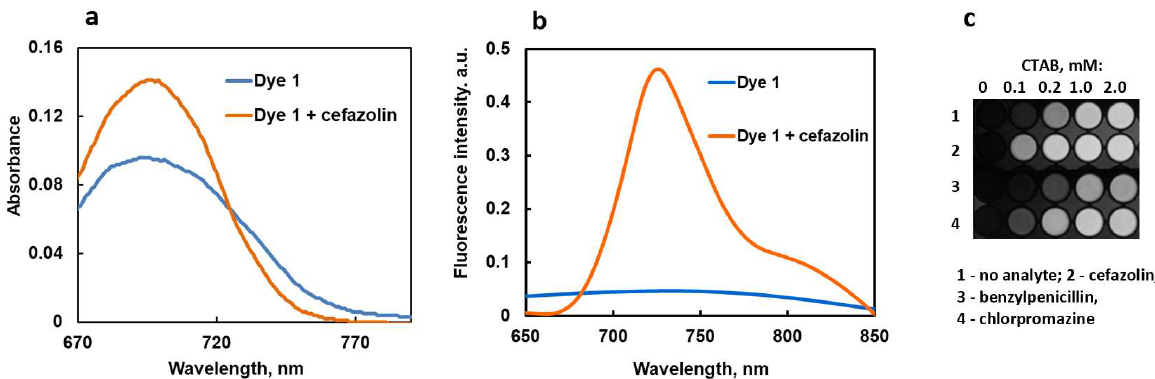
Figure 1. Effects of aggregation: absorbance spectrum change ( a ) and near-IR fluorescence enhance- ment ( b ) of dye 1 in the presence of cefazolin and CTAB; ( c ): images of the wells with varying con- centration of CTAB for three analytes (0.5 mM analyte, 0.1 mM CTAB, 2.5 mg/L dye 1, pH 7.4).